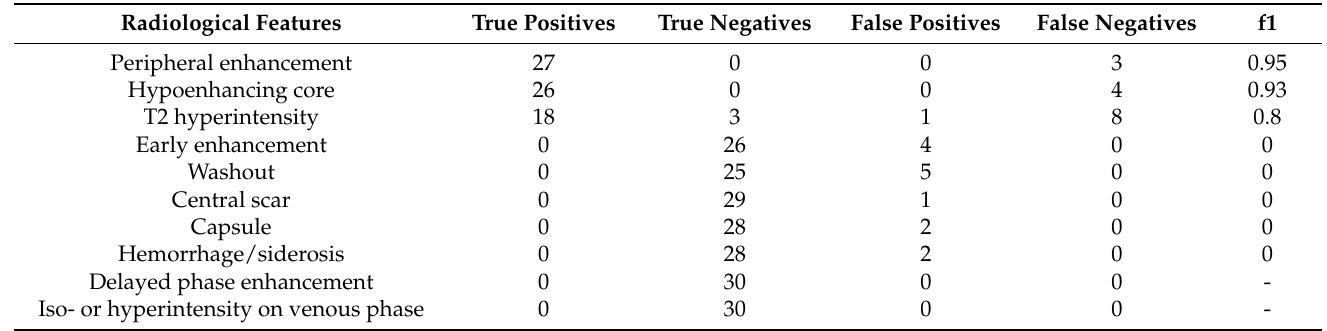
Table 6. Results for annotated features: liver